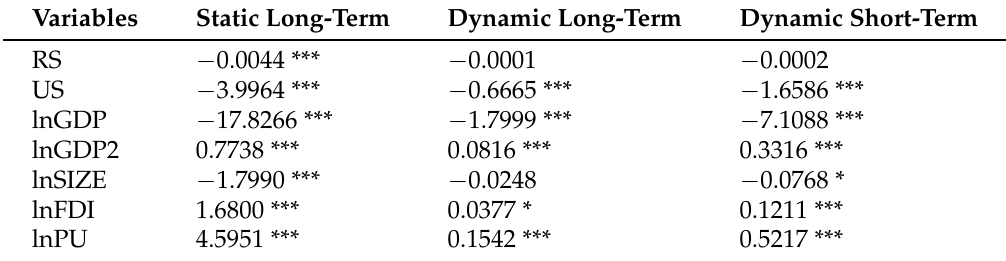
Table 9. Spatial spillover